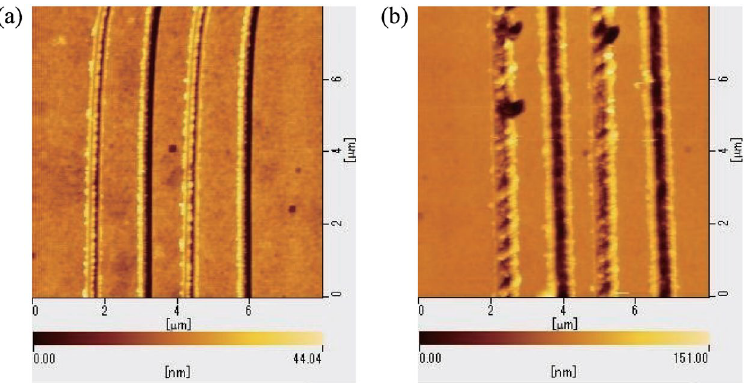
Figure 8. AFM image ( a ) and ( b ) show the grooves cut under 400 µ N pressing load with the external excitation cutting method and the self-excitation cutting method, respectively.